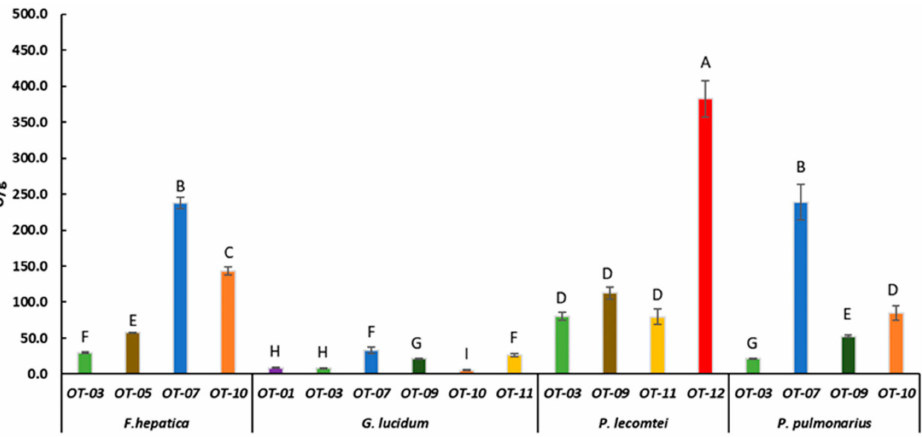
Figure 1. Laccase activity of F. hepatica BRM 047114, G. lucidum BRM 055670, P. lecomtei BRM 044603 and P. pulmonarius BRM 055674 after 28 days cultivation on starchy substrates based on sorghum grain. ST = Substrates based on sorghum grain (Table 1). Mean values of triplicates followed by the same letter do not differ according to the ScottKnott test at a 5% significance level. Bars are standard deviations.